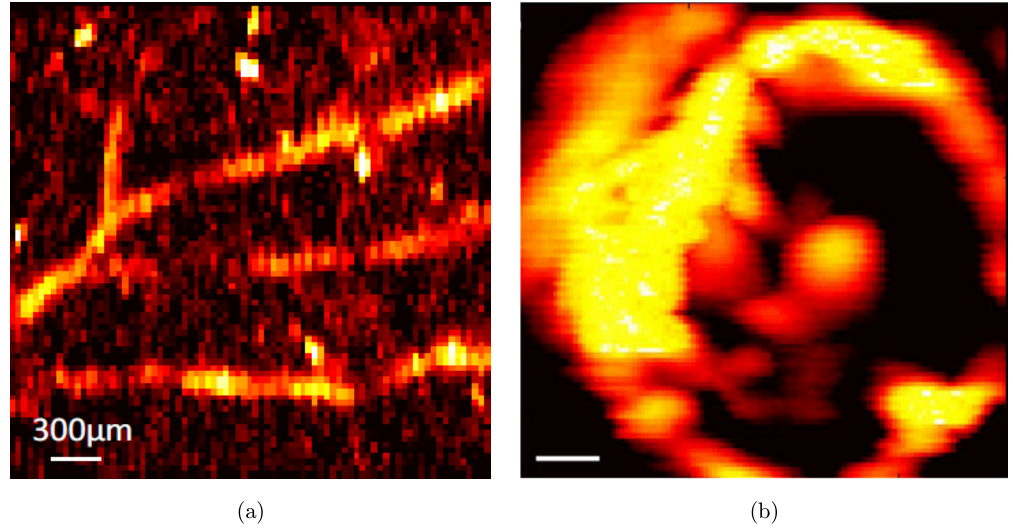
Fig. 6. (a) and (b) Photoacoustic images of mouse ear and porcine ovary (images adapted from Refs. 85, 86).